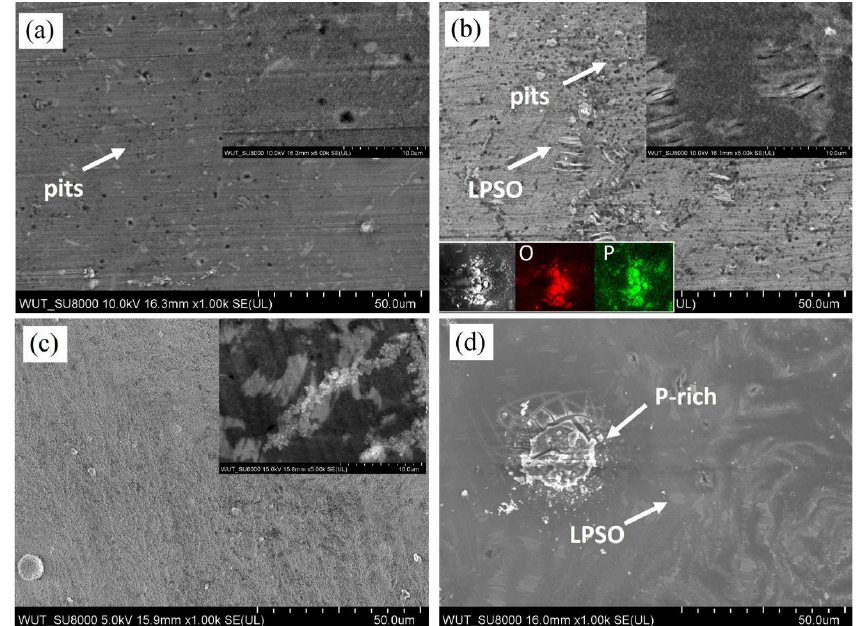
Figure 8. Characterization of corroded surfaces of WZ42 after 1 h of immersion in naturally aerated ( a ) 0.01 M NaCl, ( b ) 0.1 M NaCl, ( c ) 1 M NaCl, and ( d ) PBS.